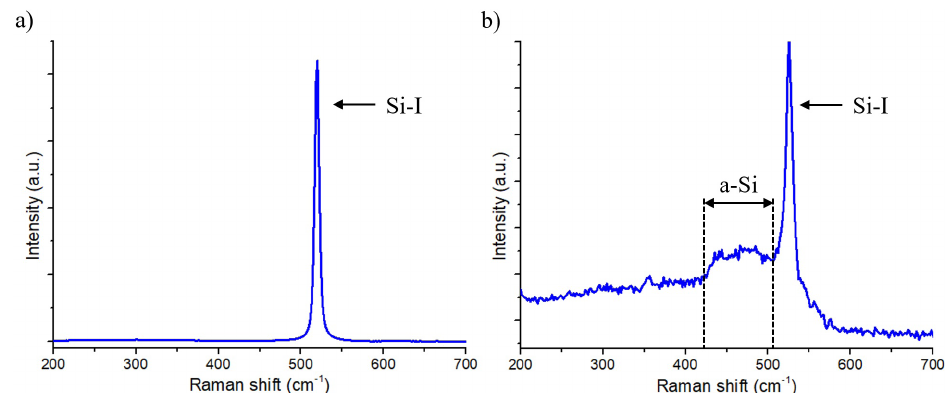
Figure 8. Phase transformation of sawn surface of mono-Si